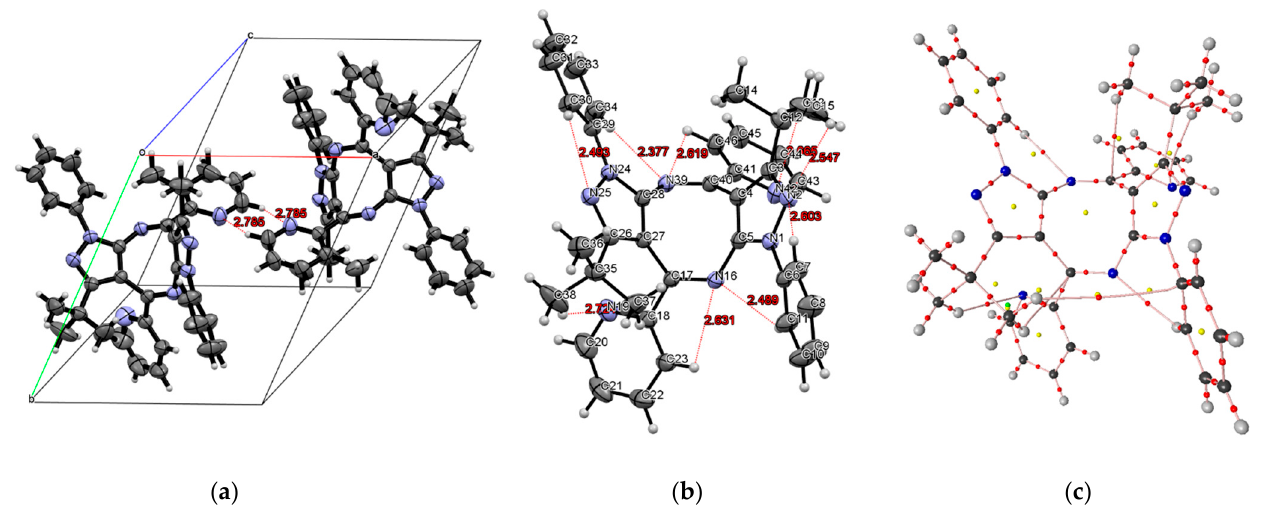
Figure 3. Crystalline structure of 1,5-diazocine derivative 8 . ( a ) Unit cell containing a symmetric cyclic dimer formed between the two molecular units ( Z = 2, Z ′ = 1). ( b ) ORTEP 3D-representation of one molecular unit with the atom numbering. Inter- and intra-molecular HB contacts are presented in dashed red lines with distances (Å) in red. Displacement ellipsoids are drawn at 50% probability level. ( c ) Molecular graph for molecular unit showing bond paths (pink lines), BCPs (red dots), RCPs (yellow dots), and CCPs (green dots).